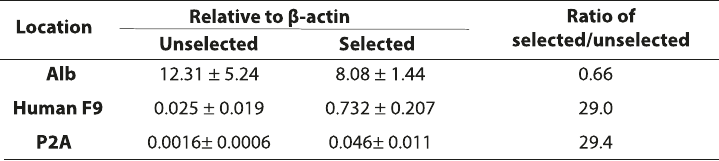
sequencing of mouse Albumin, human F9 or P2A relative to mouse β -actin in mice that received the GR-Cypor scgRNA and were APAP selected ( n =3) or remained unselected( n =3).Errorisstandarddeviation.kb:kilobases; P <0.05,** P <0.01and n.s not signi fi